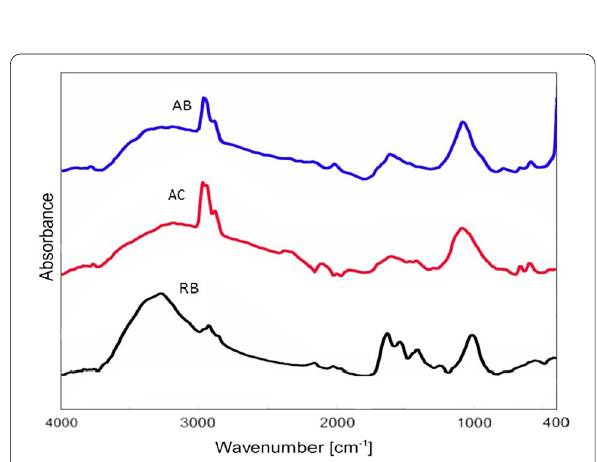
Fig. 3 FTIR bands for RB, AC, and